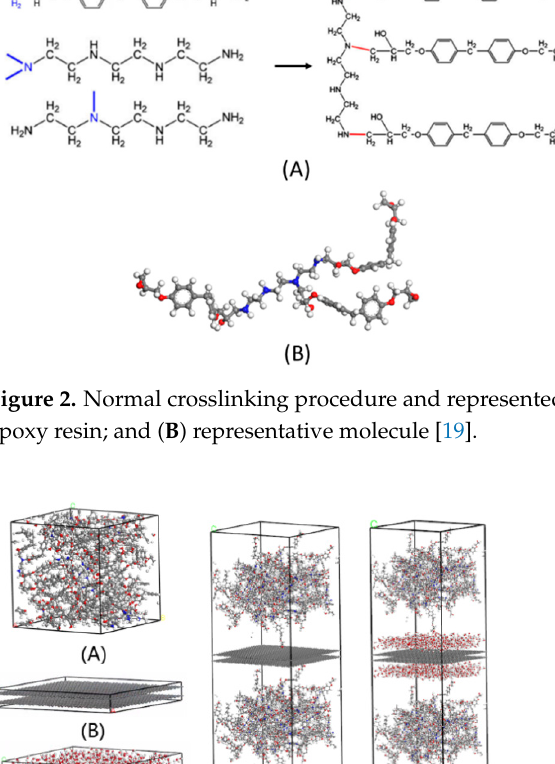
Figure 2. Normal crosslinking procedure and represented molecule. ( A ) crosslinking procedure of epoxy resin; and ( B ) representative molecule [19].